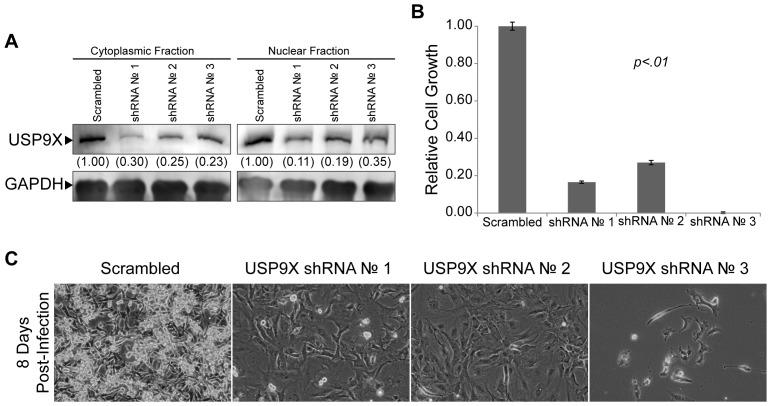
Knockdown of USP9X in U87 GB cells.(A) Western blot analysis to verify the knockdown of USP9X in U87 GB cells following infection with lentiviruses to introduce constitutively active shRNA against USP9X transcripts. Nuclear and cytoplasmic protein fractions were prepared 4 days after infecting cells with lentiviruses. USP9X levels are quantified, and levels in the Scrambled control are set to 1.00. (B) Cell growth was examined in triplicate by MTT assay 5 days after being plated at 1.5×104 cells per well of a 12-well plate. The data shown are averages relative to the Scramble control. Error bars represent standard deviation. P values were determined by student t-test and found to be <.01 for both USP9X shRNA 1, 2 and 3. (C) Photomicrographs of U87 GB cells following knockdown of USP9X using lentiviral delivered shRNA constructs against USP9X transcripts. On day 0, cells were infected with USP9X shRNA lentiviruses. Beginning on day 1, infected cells were selected using puromycin for 48 hours. On day 4, cells were passaged into fresh culture flasks (5×105 cells per flask) and photographed on day 8 post-infection.